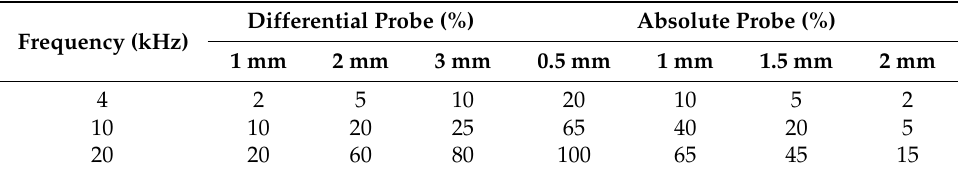
Figure 10. Integrated Probe Output without Coating Thickness. The plate with coating thickness will affect the measurement of the defect caused by the resistance of coating itself. The rate of frequency for traveling at the plate or pipe will be reduced and the defect measurement reading will be impaired. To reduce the resistance of coating in measurement, the utilization of an absolute probe is hence useful. Figure 11 shows the graph of integration between the absolute probe and differential probe in measuring the thickness of the